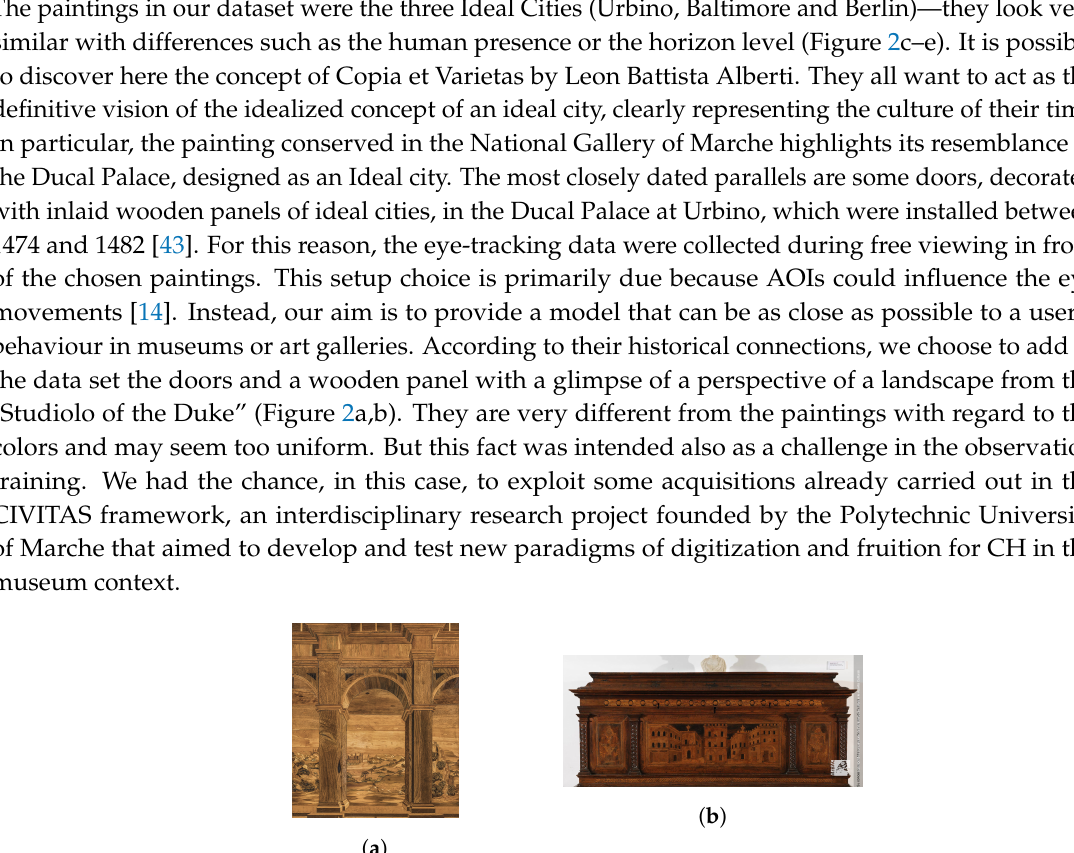
registered was 75 s, 15 s for each image. We performed a pre-test, useful for comparing the